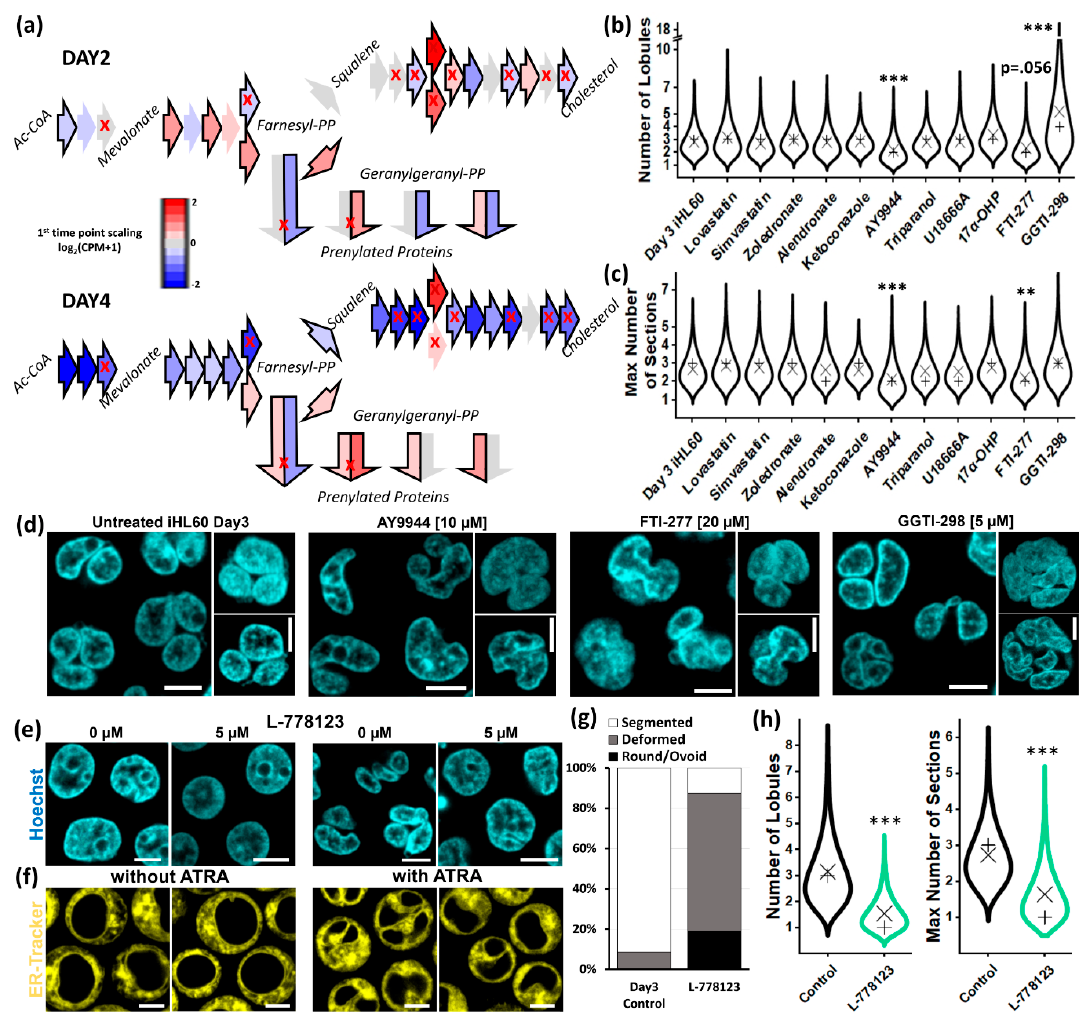
Figure 4. Effect of cholesterol pathway inhibitors on lobulation. ( a ) Cholesterol biosynthesis pathway, shown as sequence of enzymatic reactions with each arrow representing the responsible enzyme color-coded according to gene expression level against Day 0 (bold border = DEG at p < 0.001; red cross = druggable target (see Table S2); double arrows are enzymatic complexes with two subunits). ( b , c ) Quantification of number of lobules per nucleus (minimum number of quantified cells per condition = 83) and maximum number of sections (minimum number of quantified cells per condition = 91) in iHL60 differentiated in presence of the indicated drug (× = mean; + = median; ** = p < 0.01, *** = p < 0.001, Kruskal–Wallis test with Dunn post hoc comparison). ( d ) Representative pictures of live-